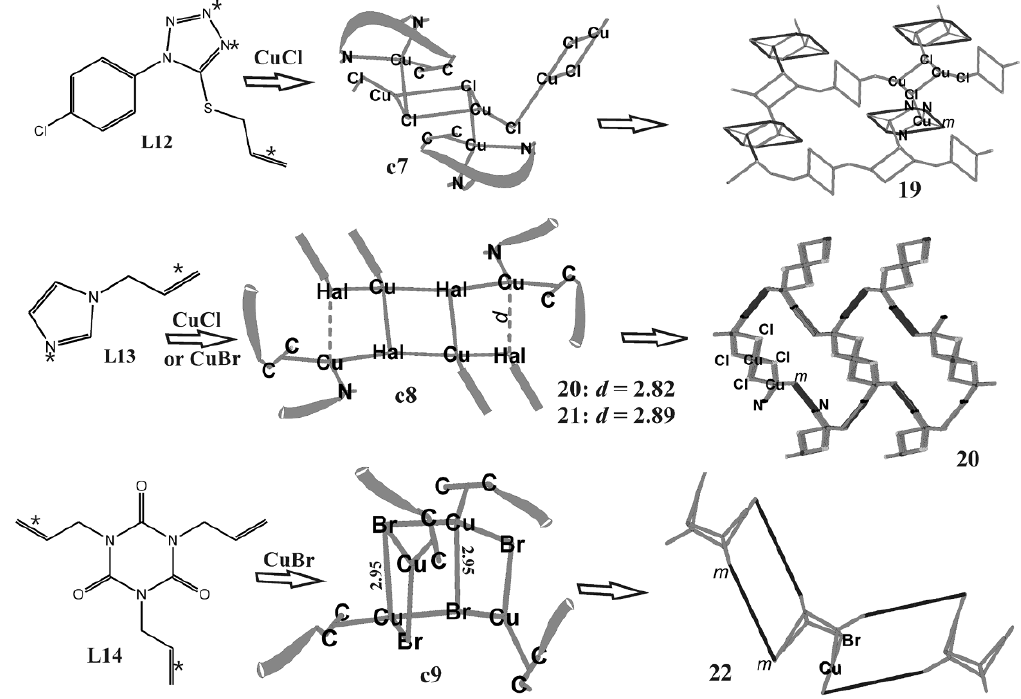
Figure 5. Structural genesis of C7-C9 fragments in 19-22